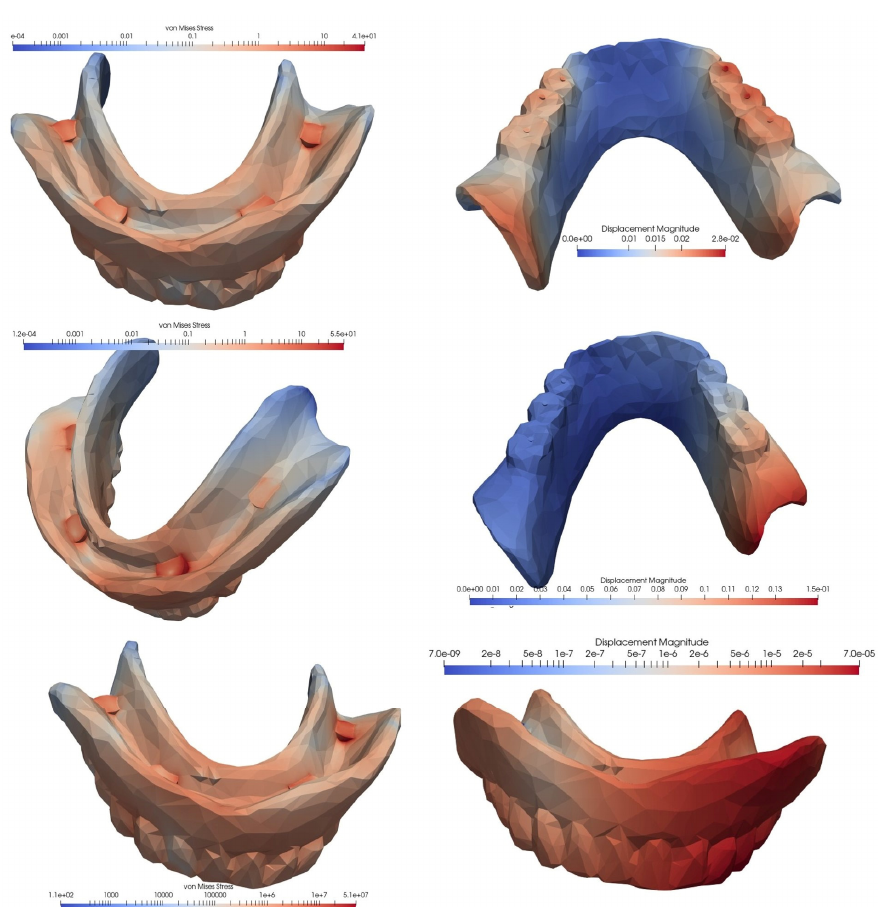
Figure 9. The von Mises stresses and displacements generated by the bilateral loading of an over- denture on four MDIs, two of which are inserted in the canine area and two in the molar area ( top ), compared to the situations of loss of an implant in the molar area ( middle ) or the canine area ( bottom ). Table 2. Biomechanical changes under the conditions of the loss of an implant in the canine or molar area for the mandibular overdenture on four MDIs, two of which were inserted in the canine area and two in the molar area. Four